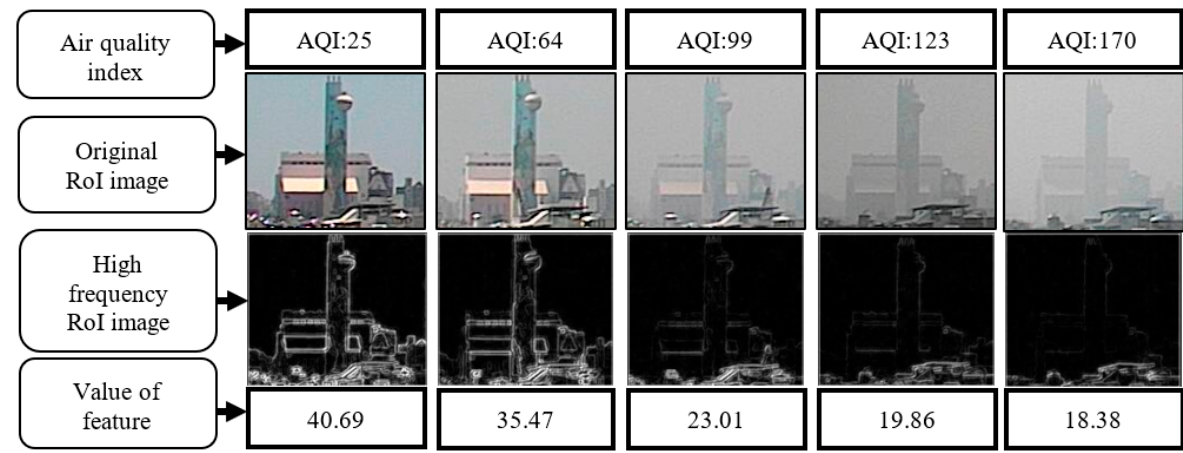
Figure 8. High-frequency images and feature values corresponding to different AQI values.